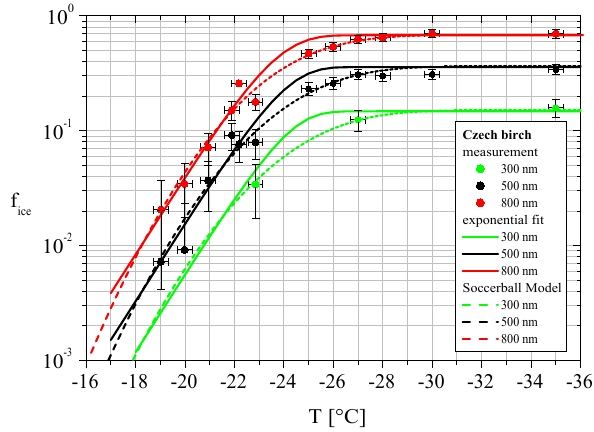
Fig. 5. Ice fraction f ice as a function of temperature T for 300, 500 and 800nm Czech birch pollen washing water particles (dots) and model calculations for the different sizes (lines) where J het was calculated based on a simple exponential fit of J het (straight line) or based on the SBM (dotted line) (see Fig.4). Least-mean square values for 300, 500 and 800nm particles are 0 . 144, 1 . 180 and 0 . 760 for the simple exponential fit of J het and 0 . 004, 1 . 020 and 0 . 428 for the SBM, respectively.